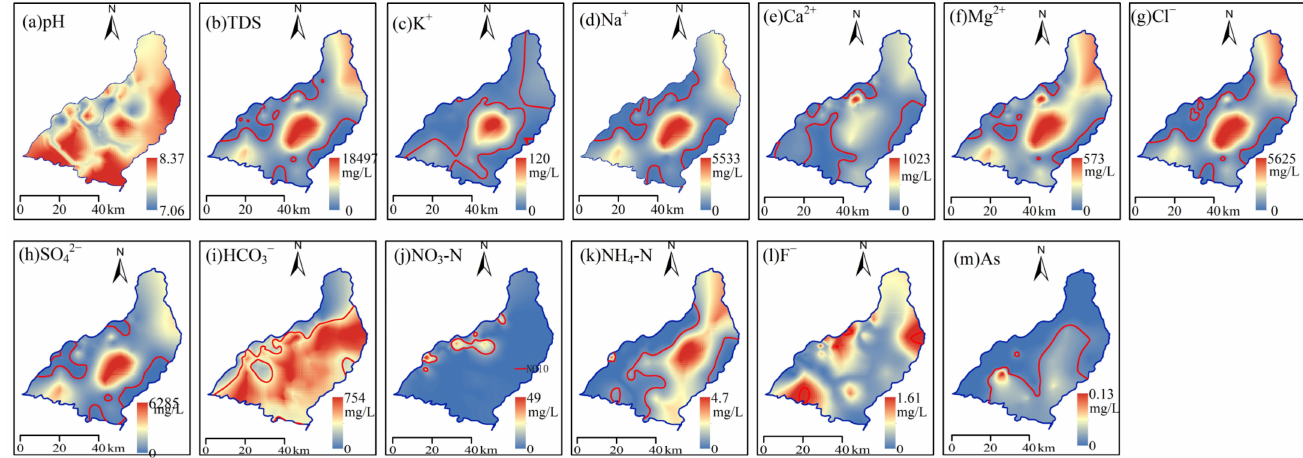
Figure 3. Geographic visualization of the hydrogeochemical variables: ( a ) pH; ( b ) TDS; ( c ) K + ; ( d ) Na + ;( e ) Ca 2+ ; ( f ) Mg 2+ ; ( g ) Cl − ; ( h ) SO 42 − ; ( i ) HCO 3 − ; ( j ) NO 3 -N; ( k ) NH 4 -N; ( l ) F − ; ( m ) As. The red line represents the WHO limit